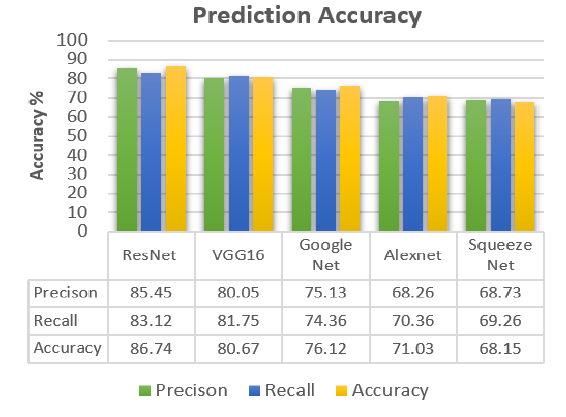
Figure 10. Prediction Accuracy.